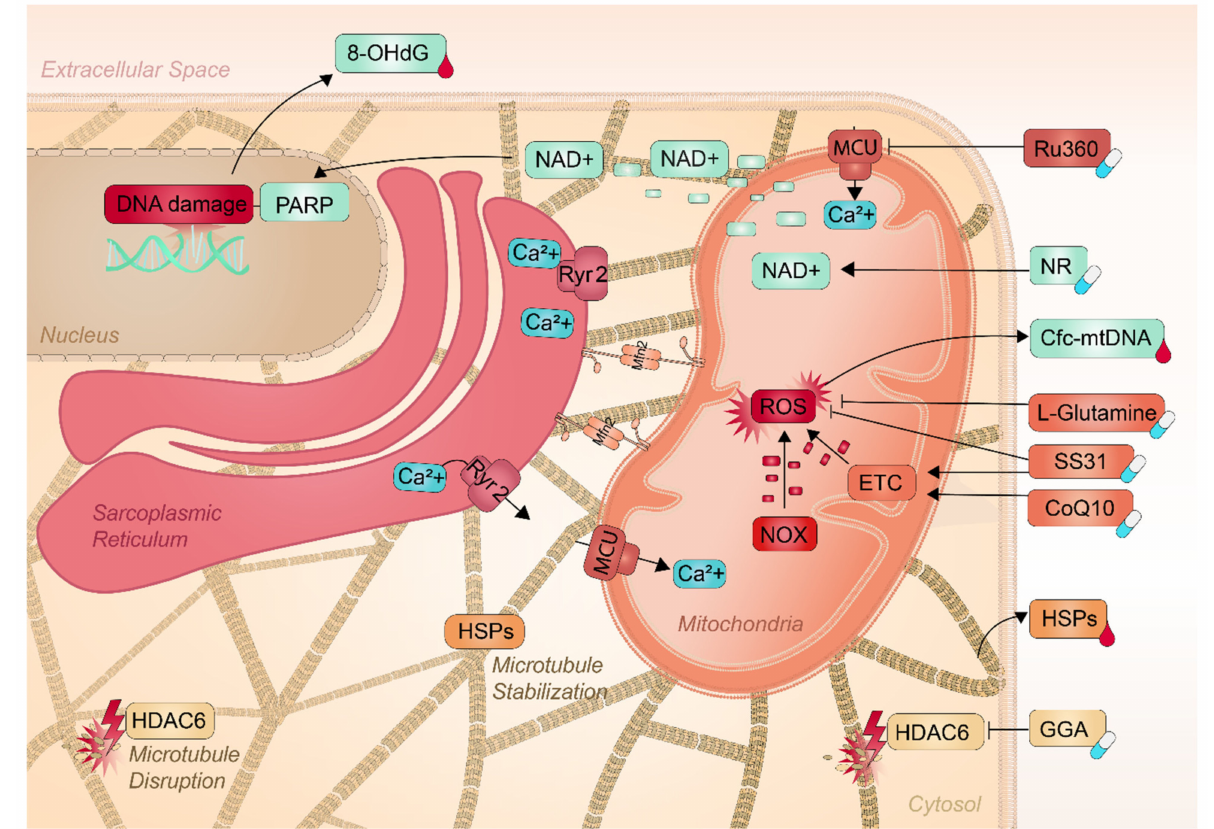
Figure 3. Schematic overview of the pathophysiological processes during AF and the potential biomarkers and therapeutic implications. Mitochondrial dysfunction has been identified as a contributing factor in AF. Modulators of mitochondrial dysfunction such as 8-OHdG and cfc-mtDNA may aid in the staging of the severity of AF, predicting postoperative AF (POAF) onset, and the outcome of AF treatments. In addition, various pharmaceutical- and nutraceutical compounds are under investigation nowadays. Pharmaceutical compounds such as SS31, Ru360, or HSP inducer GGA and nutraceutical compounds such as NR, L-glutamine, and CoQ10 may present novel therapeutic strategies to counteract AF-induced mitochondrial